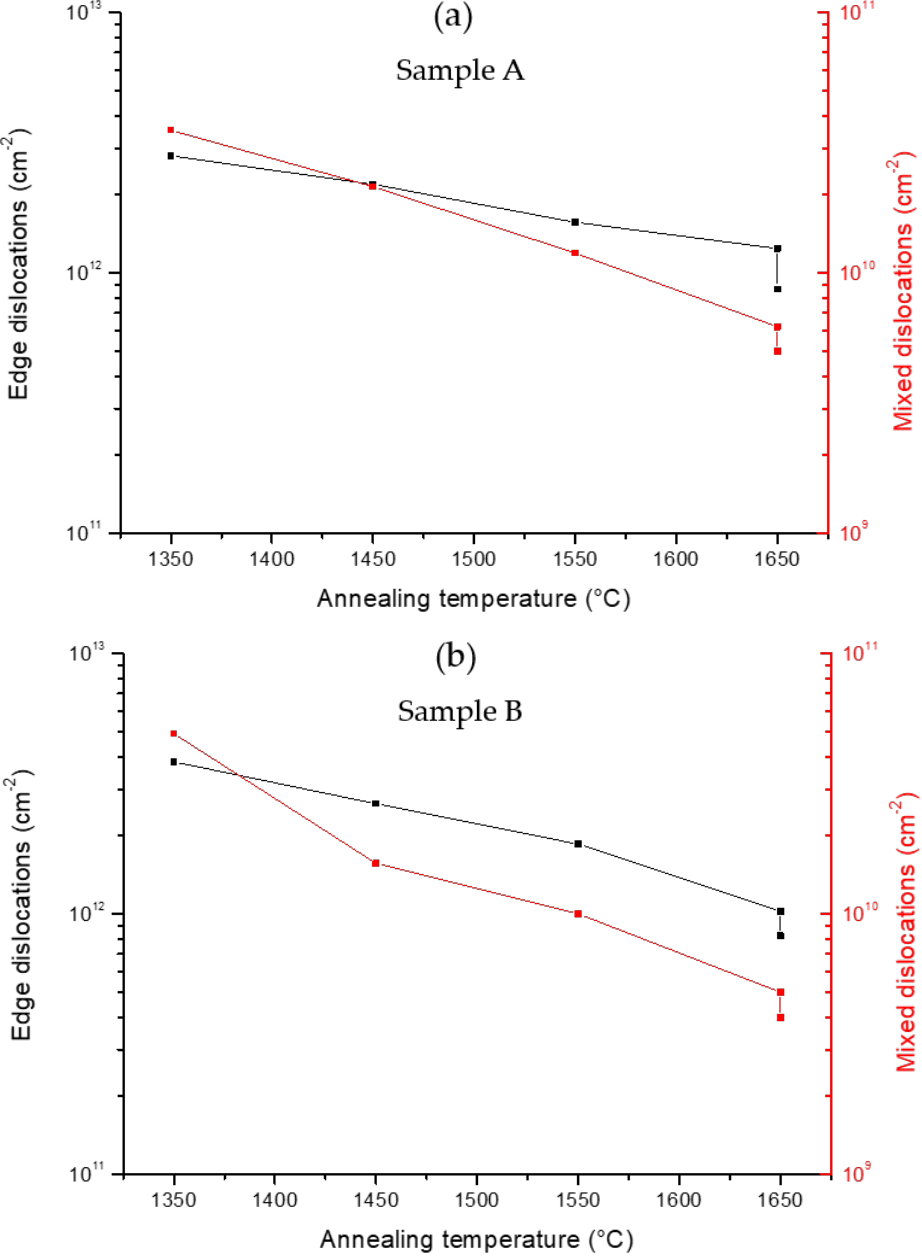
Figure 5. Mixed and edge dislocation densities of ( a ) sample A and ( b ) sample B estimated from tilt and twist values as a function of the annealing temperatures.